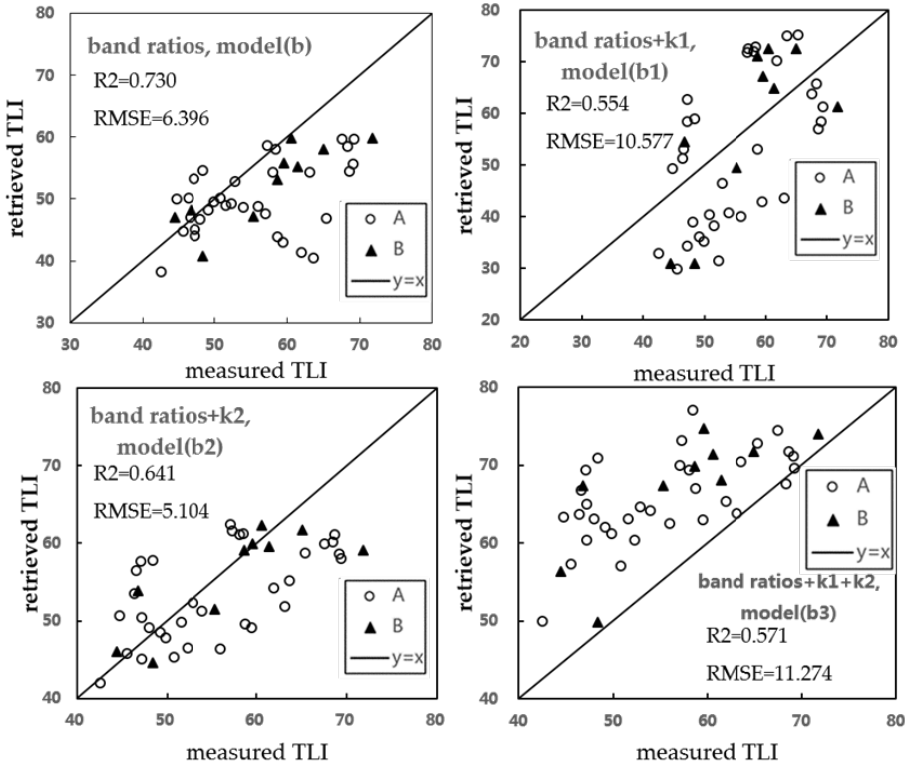
Figure 5. Scatter diagram of measured-retrieved TLI based on seven band ratios and atmospheric